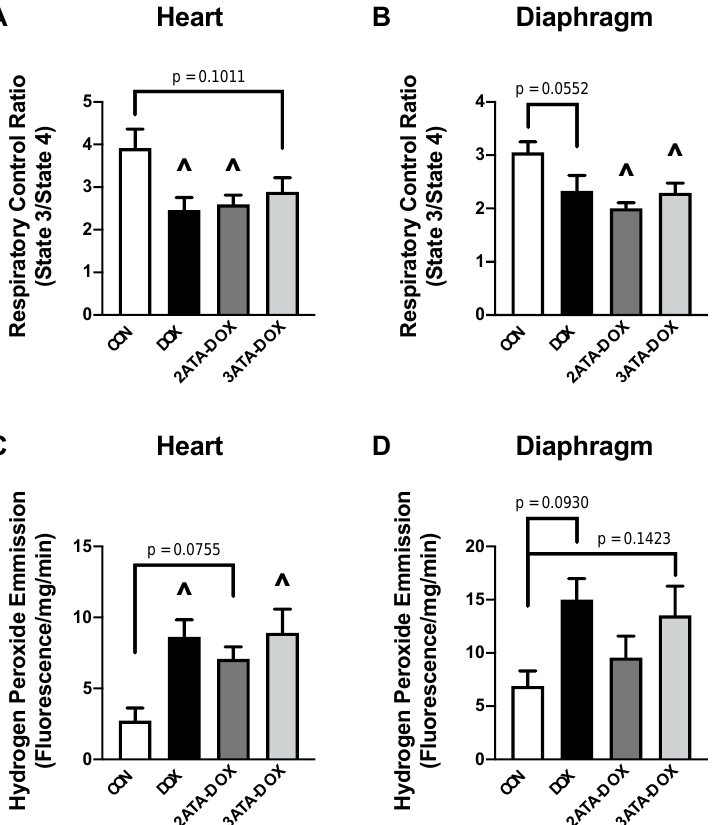
Figure 5. Mitochondrial Function and Oxidative Stress. Measurement of ( A , B ) mitochondrial respiratory control ratio and ( C , D ) mitochondrial hydrogen peroxide emission in permeabilized heart and diaphragm muscle fibers. Values are represented as means ± SEM. ^ significantly different vs. CON ( p < 0.05).